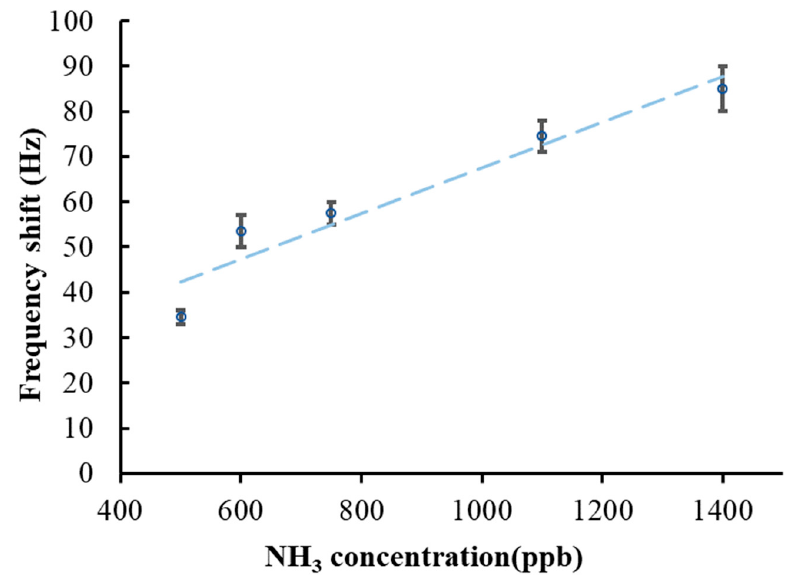
Figure 7. The frequency shift of a SAW sensor as a function of ammonia concentrations in dry air; the R 2 coefficient of determination is 0.9238. Table 1. Sensing performance of the SAW sensor toward NH 3 gas in dry